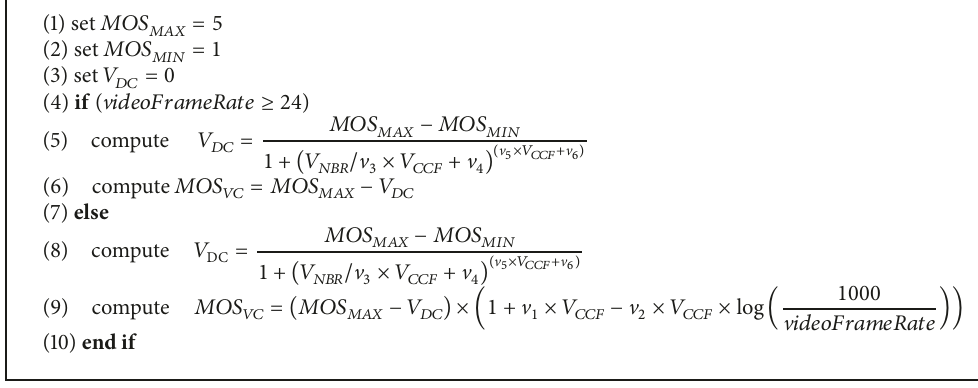
Algorithm 1: Calculation of MOS